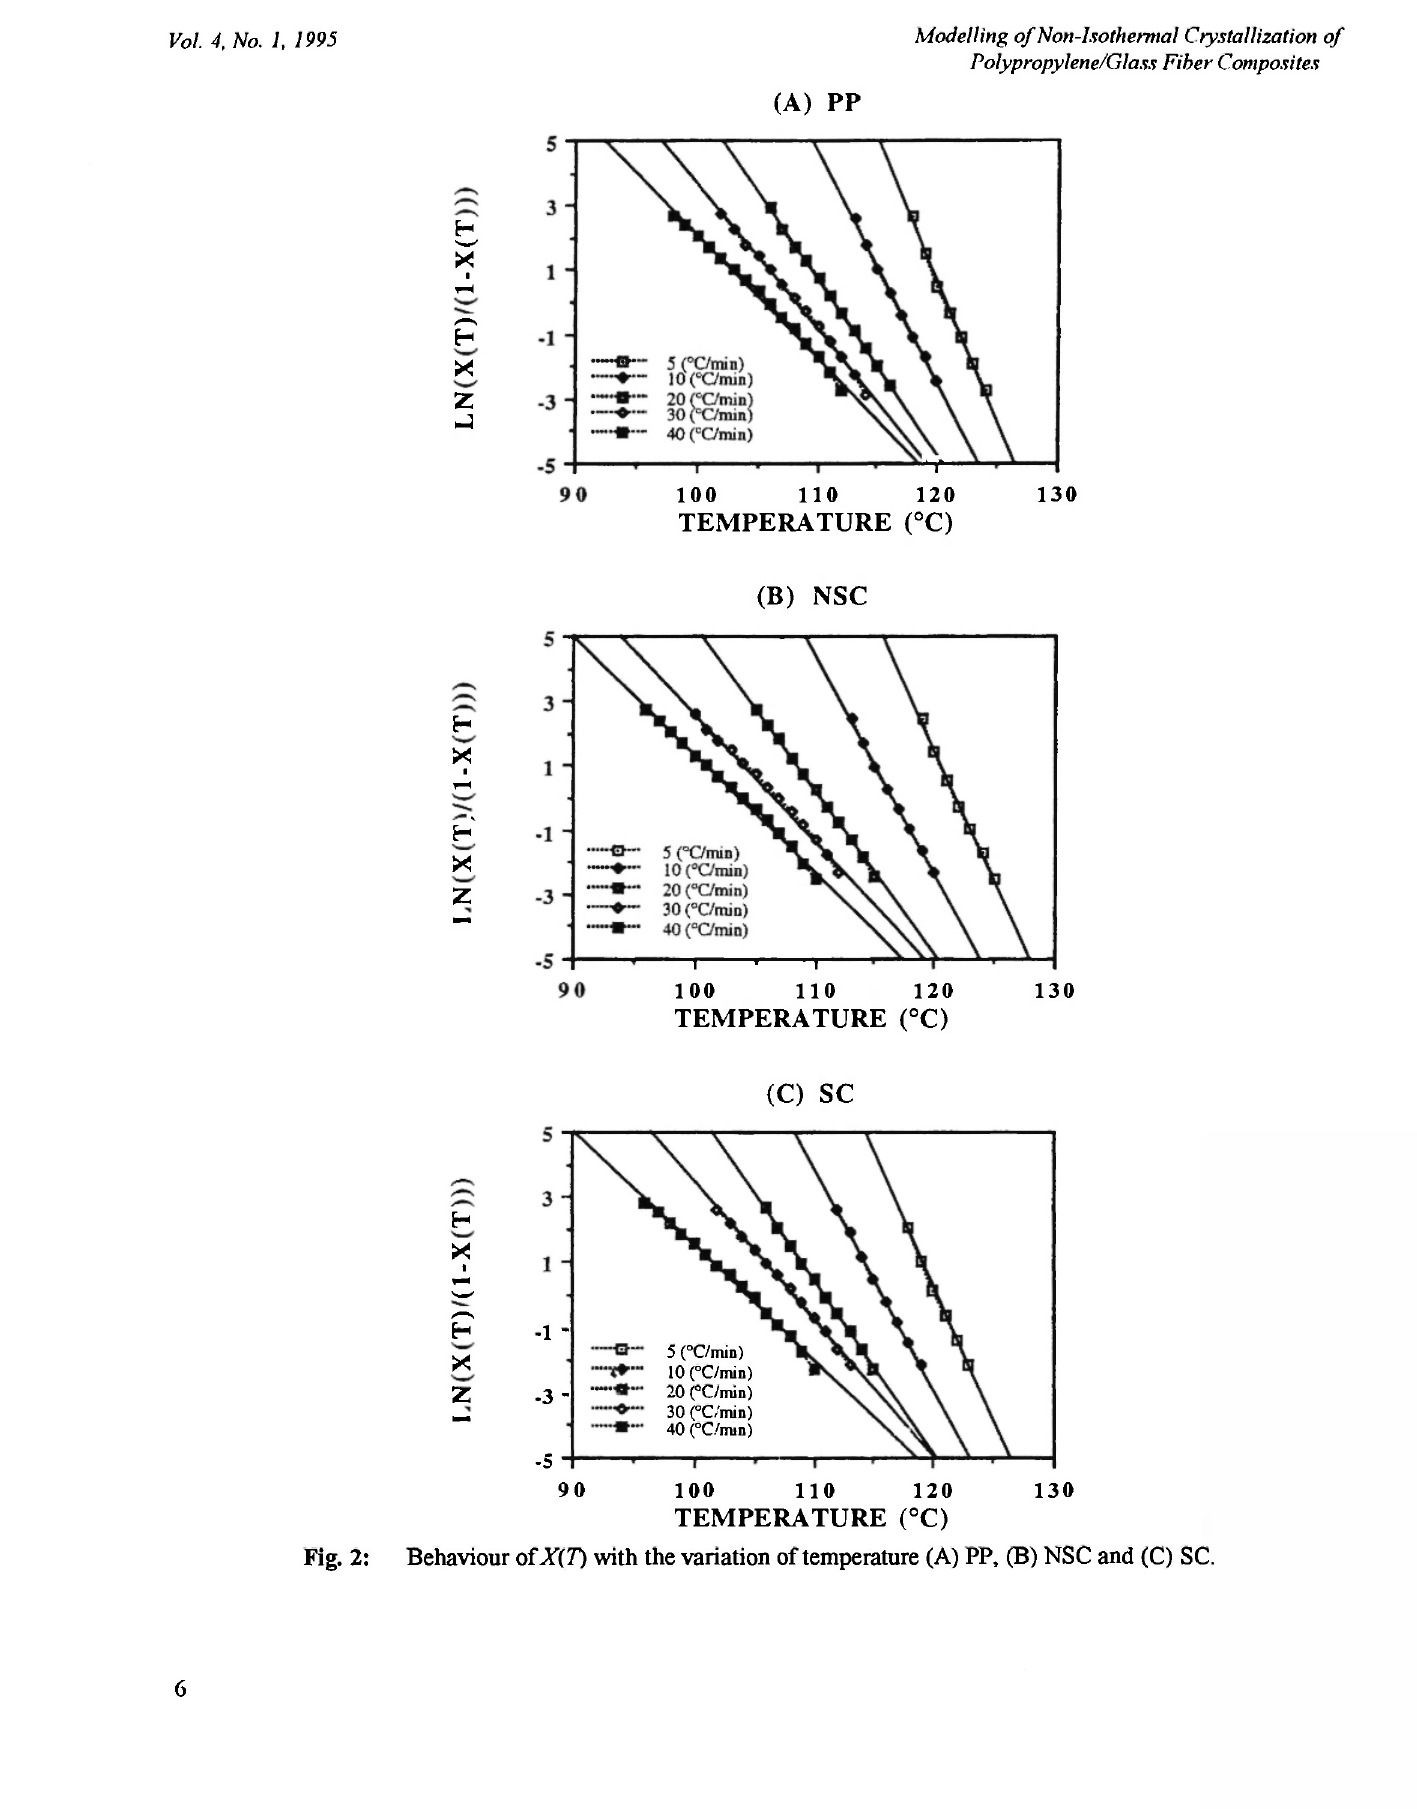
90 100 110 120 130 TEMPERATURE (°C) Behaviour οϊΧ{Τ) with the variation of temperature (A) PP, (B) NSC and (C) Fig. 2: